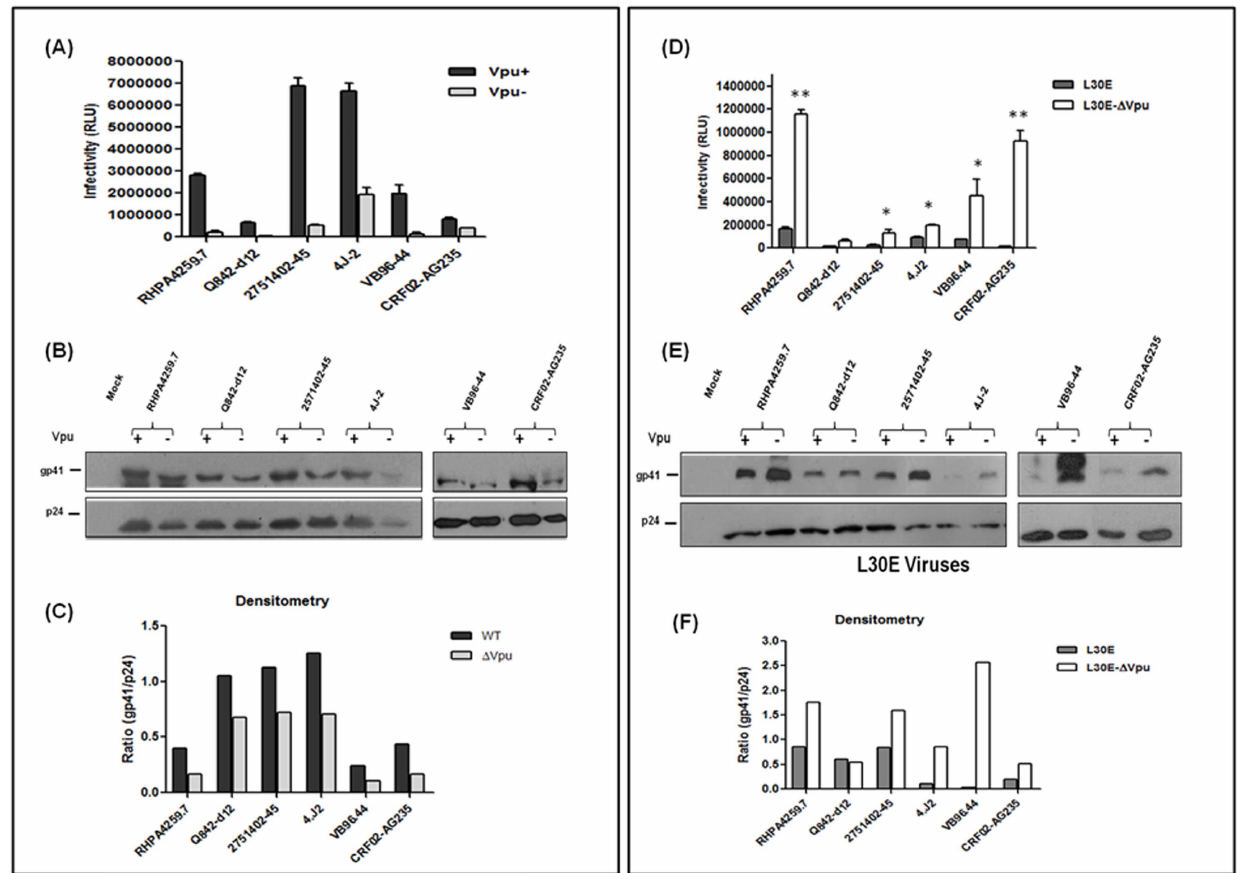
Figure 6. Effect of Vpu start codon mutation and Gag L30E mutation on infectivity and Env incorporation of primary viruses of diverse origin. Viruses were produced by co-transfection of 293T cells with combinations of Env deficient backbone plasmids containing Gag (L30E) or Vpu mutation and Env plasmids of patient origin. At 48 h post-transfection, supernatants were harvested and infectivity of viruses was determined in TZM-bl cells by measuring RLU. Average of RLU and standard error was calculated and plotted as a graph. Infectivity experiments were performed in duplicates and the results shown are representative of three independent experiments. Viral supernatants were concentrated by ultracentrifugation using 20% sucrose cushion, normalized for RT values and equal quantities were subjected to 10% SDS-PAGE gel, followed by Western blot with anti-p24 (183-H12-5C) and anti-gp41 (Chessie 8) antibody. Western blots shown represent gp41 Env on released virion particles. Viral p24 and gp41 band intensities were determined with Image J software (NIH) and ratio of gp41 to p24 was plotted in a graph to determine Env incorporation. (A) Infectivity of primary viruses in presence ( + ) and absence ( 2 ) of Vpu. (B) Western blot analysis of Vpu + and Vpu 2 primary viruses. (C) Densitometry analysis of band intensities of Vpu + and Vpu 2 viral p24 and gp41 proteins. Ratio of gp41/p24 represents the amount of Env (gp41) incorporation on virions. (D) Infectivity of primary viruses carrying Gag L30E mutation in presence and absence of Vpu. Significance level of improved infectivity of double mutant viruses (L30E- D Vpu) was determined with respect to viruses possessing Gag mutation (L30E) using Student’s t -test: * means p , 0.05 and ** means P , 0.005. (E) Western blot analysis of L30E and L30E- D Vpu (double mutant) primary viruses. (F) Densitometry analysis of L30E and L30E- D Vpu viral proteins, p24 and gp41. Ratio of gp41/p24 represents the amount of Env (gp41) incorporation on